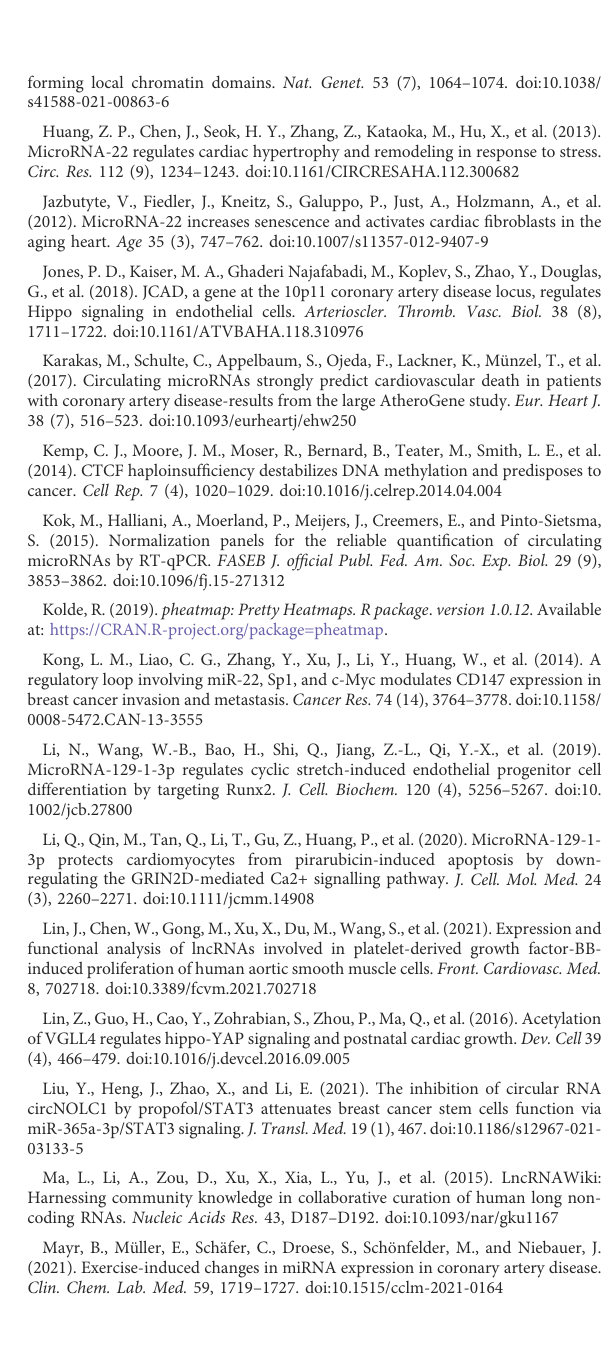
SUPPLEMENTARY FIGURE S2 PCAplotsbeforeandaftersamplecorrectionforthetwodatasets. (A) and (B) represent the PCA plots before and after sample correction with inter-batch differences removed for the GSE105449 dataset, respectively. (C) and (D) representthePCAplotsbeforeandafter samples correction with inter-batch differences removed for the GSE28858 dataset,